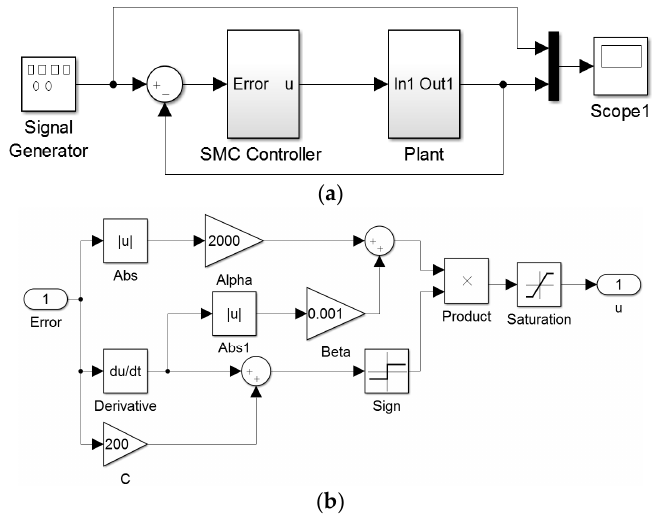
Figure 13. Simulation blocks for the controller schematic ( a ) and ( b ) its constitution. Energies 2017 , 10 , 887